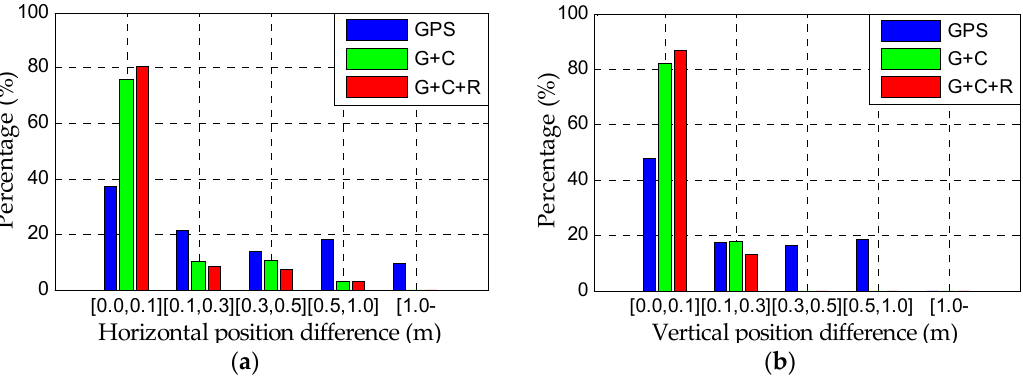
Figure 13. Distribution of the position differences of the tightly coupled RTK/INS/Vision integration for the GPS, GPS + BDS (G + C), and GPS + BDS + GLONASS (G + C + R) systems. ( a ) Horizontal; ( b ) Vertical.